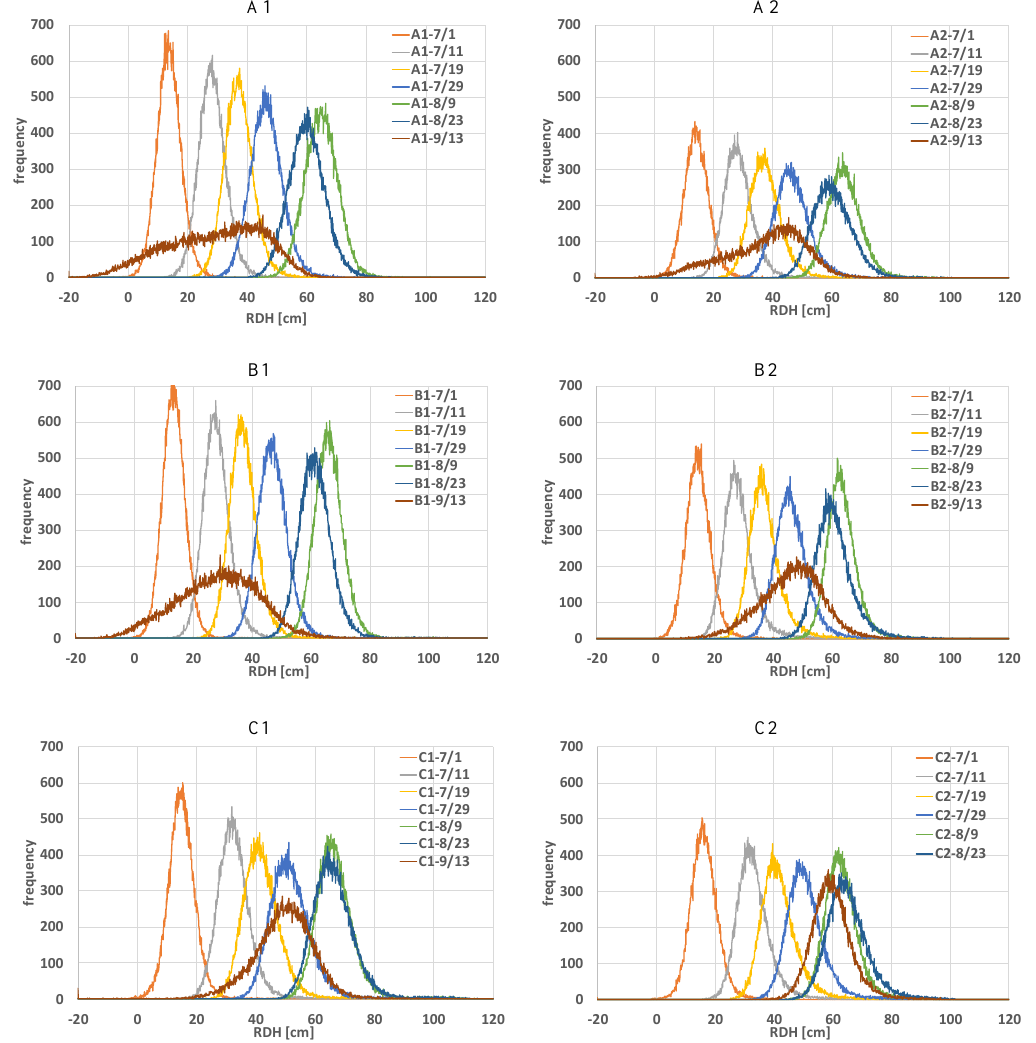
Fig.9 Histogram of each fertilization